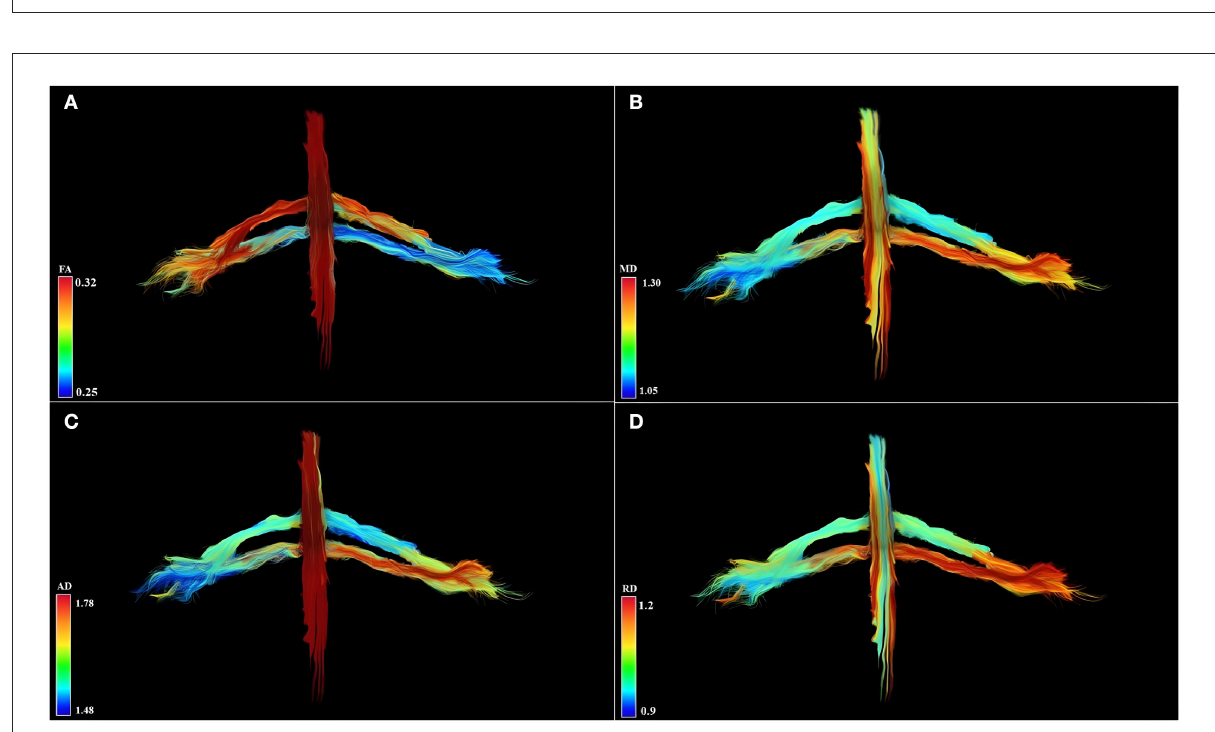
FIGURE2 Diffusion tensor imaging tractography of the cervical cord and C6 and C7 brachial roots in three-dimensional view and parametric color maps (A–D) . (A) The color of the tract is determined by the local FA, where red denotes a high FA (0.32), scaled to yellow, green, and blue denote low FA (for rater 0.25). (B) The color of the tract is determined by the local MD, where red denotes a high MD (1.30), scaled to yellow, green, and blue denote low MD (for rater 1.05). (C) The color of the tract is determined by the local AD, where red denotes a high AD (1.78), scaled to yellow, green, and blue denote low AD (for rater 1.48). (D) The color of the tract is determined by the local RD, where red denotes a high RD (1.2), scaled to yellow, green, and blue denote low RD (for rater 0.9). Geometric distribution of water diffusion parameters suggests myelin damage of left C7 root, demonstrated by reduction of FA, increase of MD, AD, and RD. Left C6 root shows reduced FA values and increased MD, AD, and RD values in distal root section, suggesting a partial compromission of the nervous